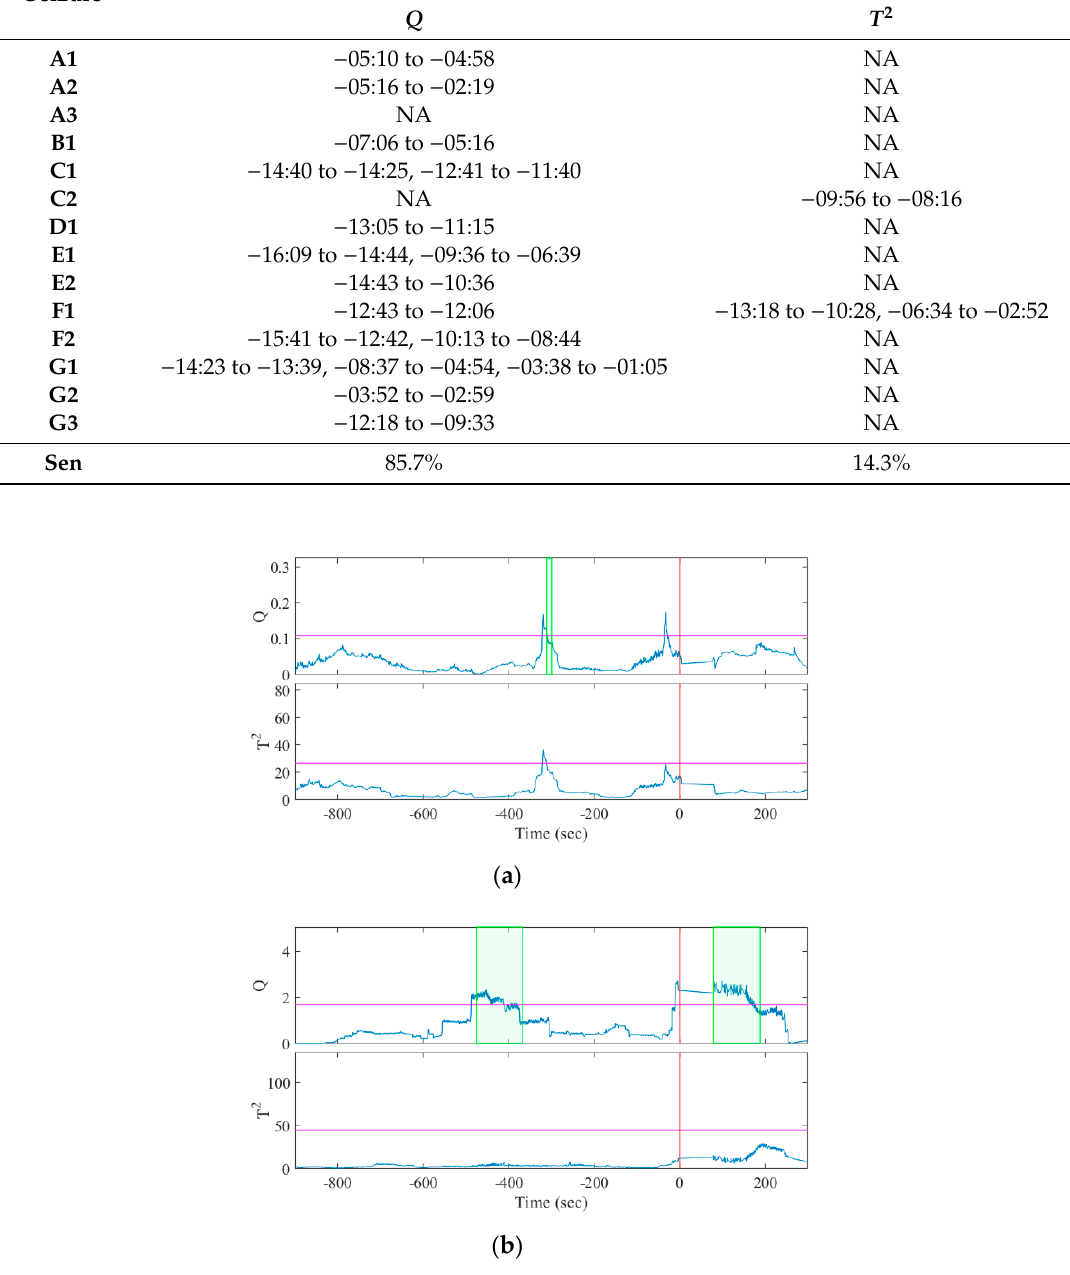
Table 5. False positive rate during interictal period.